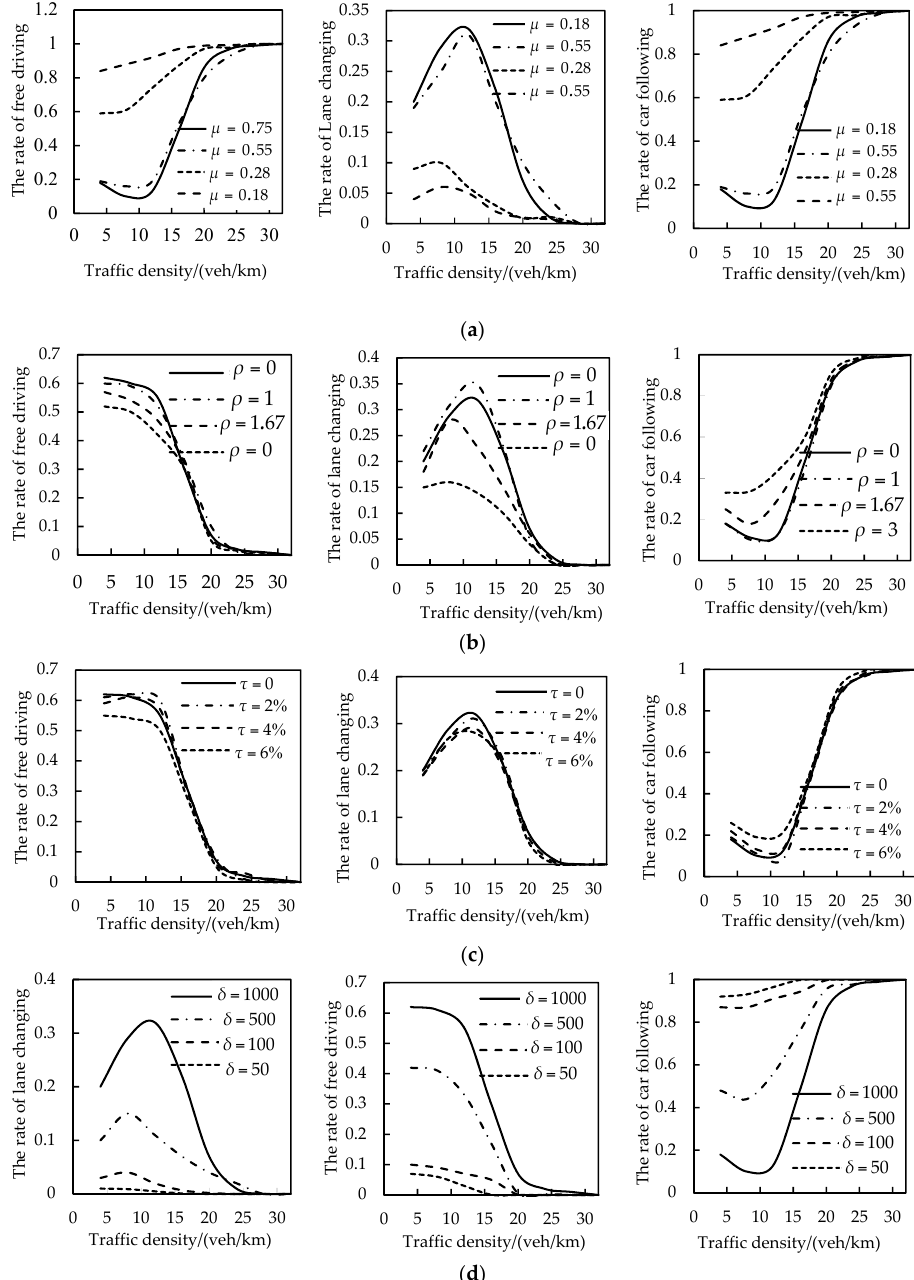
Figure 9. Driving Decision Rate under Different Road Conditions. (The horizontal axis in these diagrams represents the traffic flow density, and the vertical axis represents the rate of each driving decision (between 0 and 1). The solid lines in all diagrams represent the changing trend of the proportion of driving decisions with traffic density under standard road conditions. ( a ) The changing trend of each driving decision rate with traffic density when µ takes different values; ( b ) The changing trend of each driving decision rate with traffic density when ρ takes different values; ( c ) The changing trend of each driving decision rate with traffic density when τ takes different values; ( d ) The changing trend of each driving decision rate with traffic density when δ takes different values. From left to right, each column represents the trend of lane changing rate, free driving rate and car-following rate with traffic density when each road parameter is taken as different values,